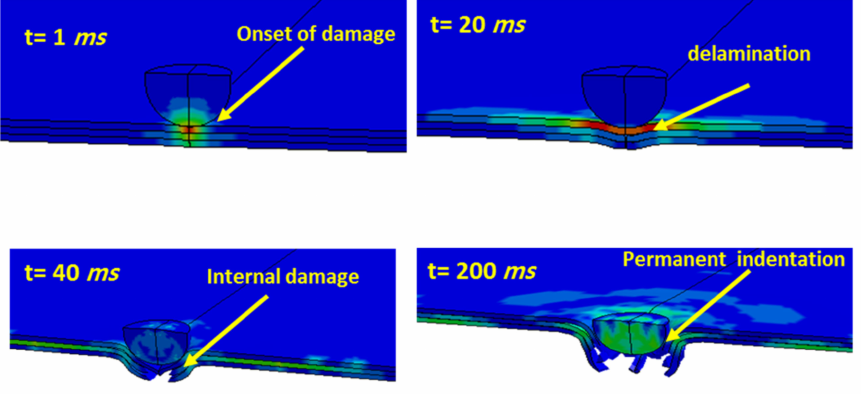
Figure 3. A damaged hybrid composite laminate under low-impact